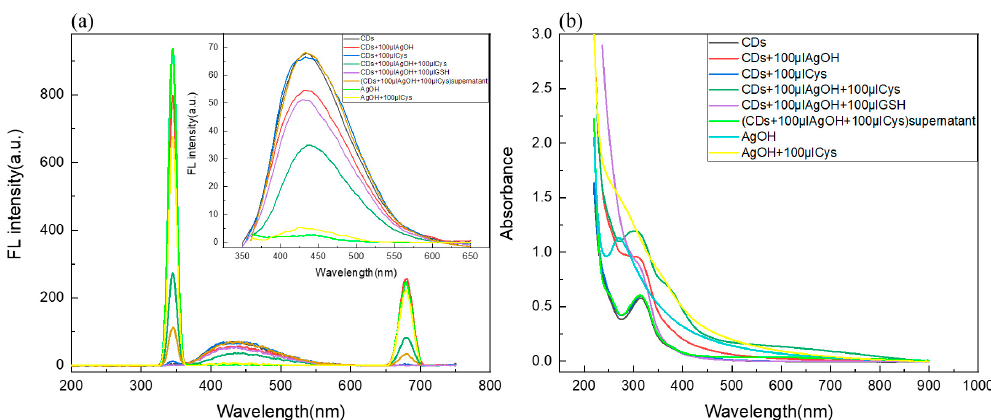
Figure 4. ( a ) The RLS intensity of the C/N-dots–Ag + complex system with the addition of Cys and GSH; the insets corresponded to FL changes; ( b ) The corresponding UV-Vis absorption spectra of the above solution.